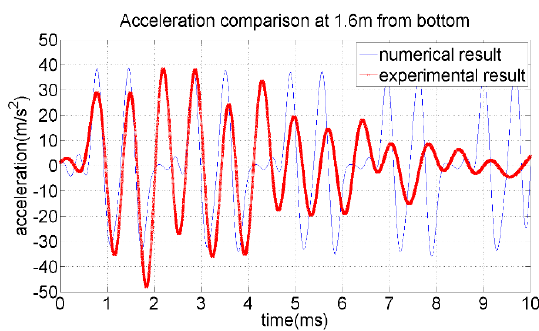
Figure 8. Comparison between experimental and numerical results using the frictional contact method.